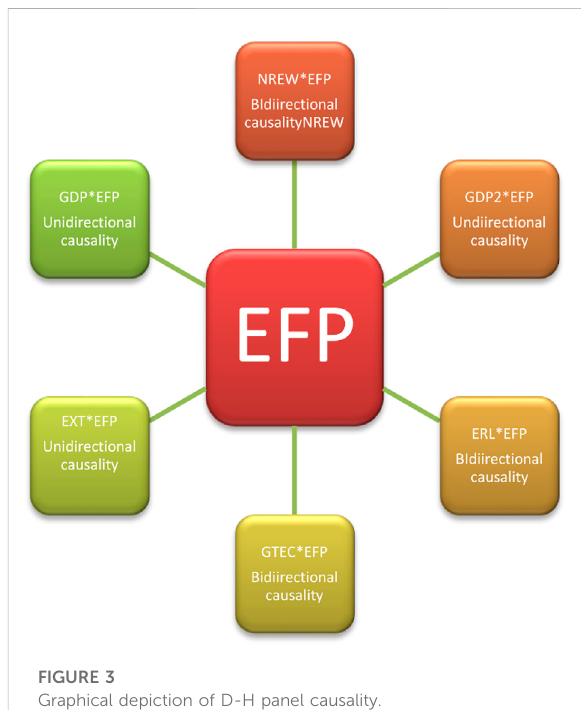
FIGURE 3 Graphical depiction of D-H panel